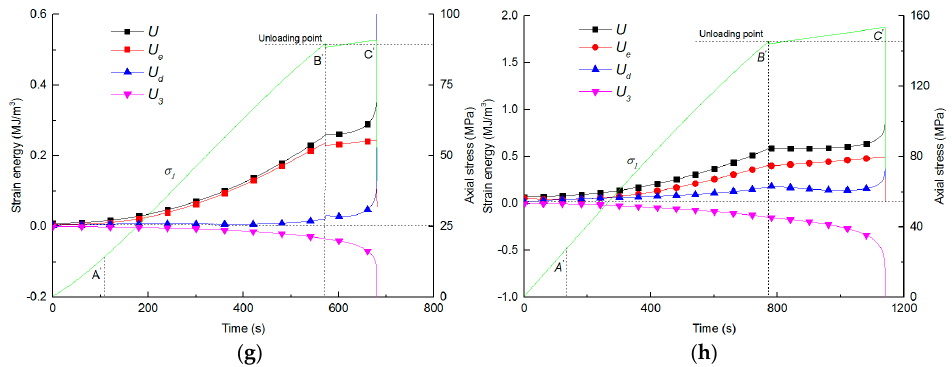
Figure 9. Typical strain energy and axial stress time curves: ( a ) TC-D-10; ( b ) TC-D-40; ( c ) TC-S-10; ( d ) TC-S-40; ( e ) TU-D-10; ( f ) TU-D-40; ( g ) TU-S-10; ( h ) TU-S-40.